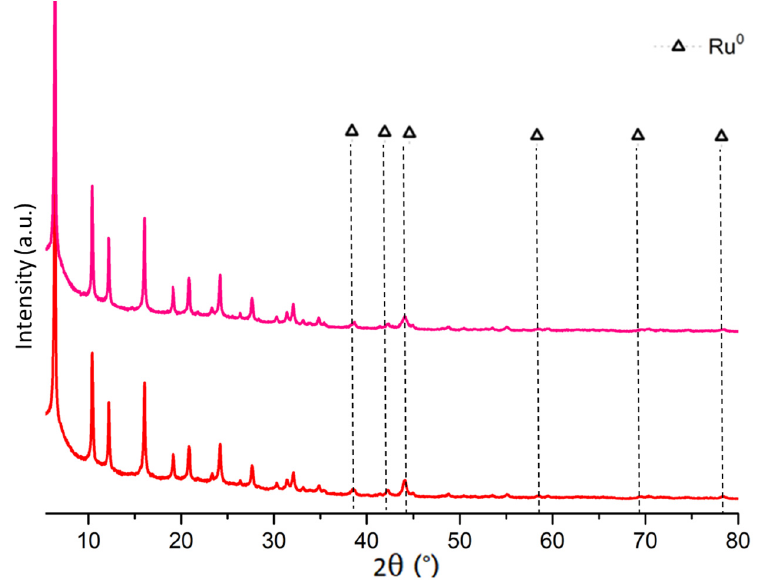
Figure 10. XRD patterns acquired for 3Ru/CsUSY catalyst after reduction (in red) and after plasma-catalytic experiments (in purple).